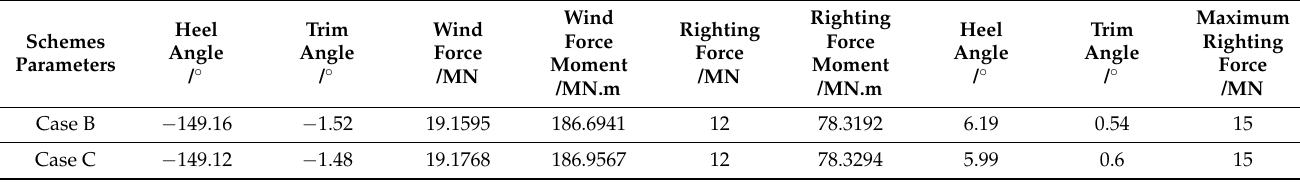
Table 2. Wind force and righting force of case